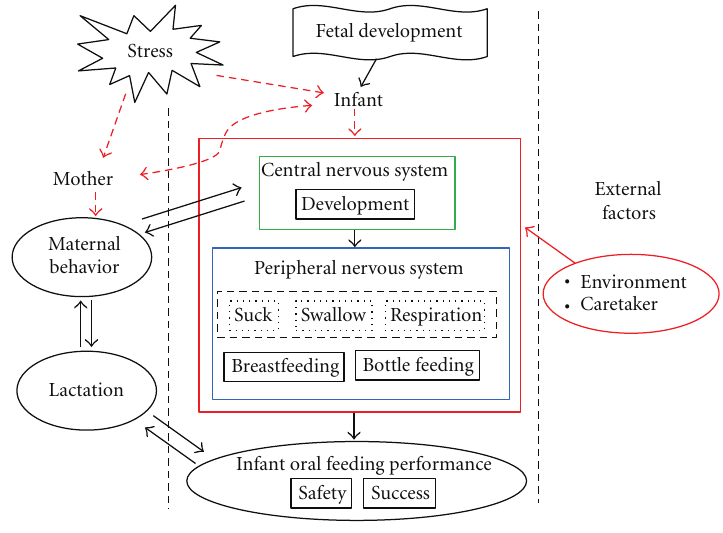
Figure 1: Oral feeding